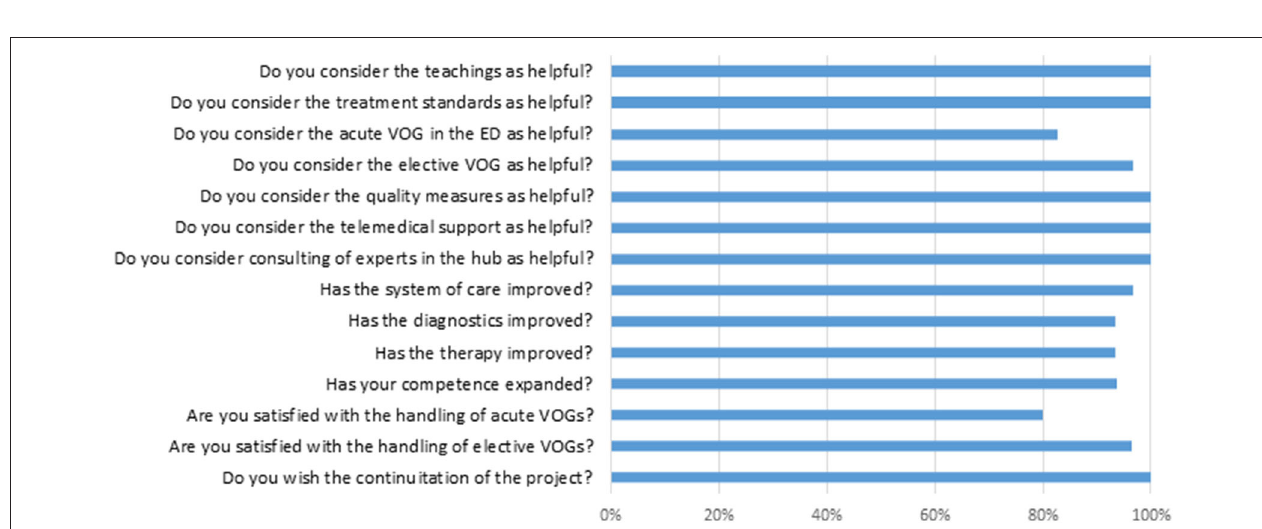
FIGURE 5 | Subjective user assessment for acute and elective videooculographies. Rates of positive answers.